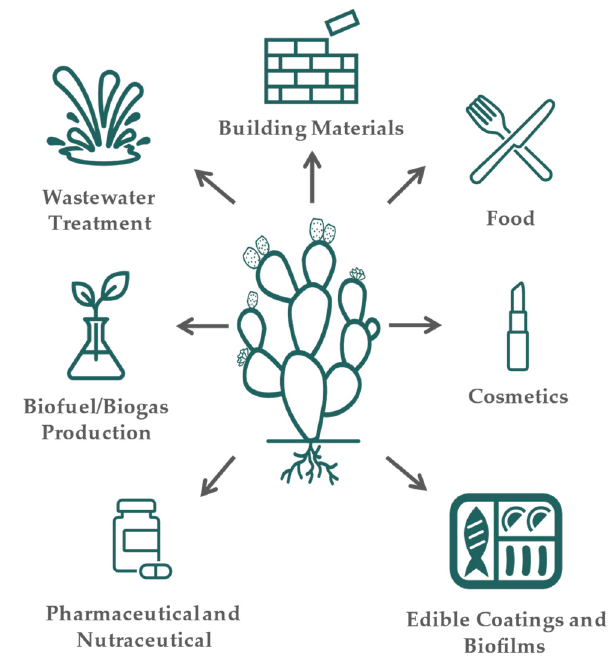
Figure 1. Cladode applications.